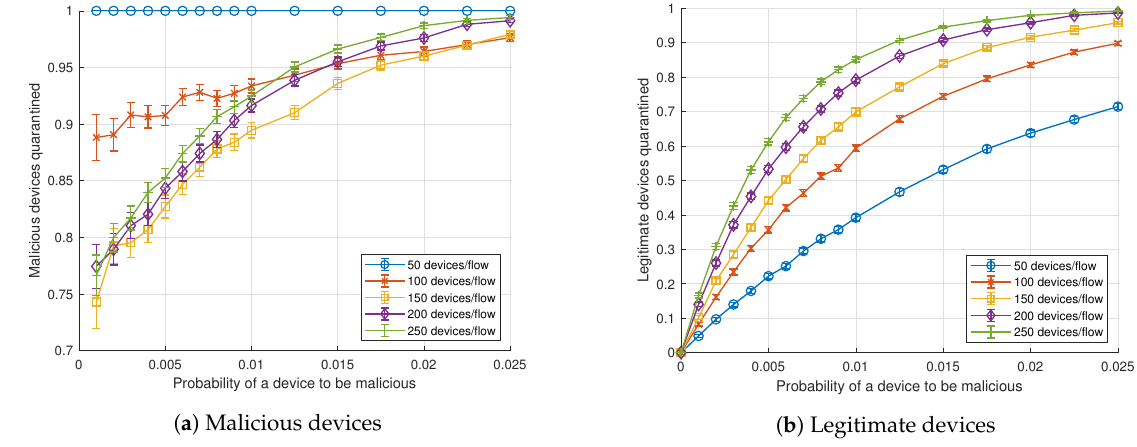
Figure 2. Ratio of devices quarantined as a function of the probability of a device to be malicious, p m ( s p = 1s, t r = 1.01, f m = 100), for n ∈ { 50,100,150,200,250 }